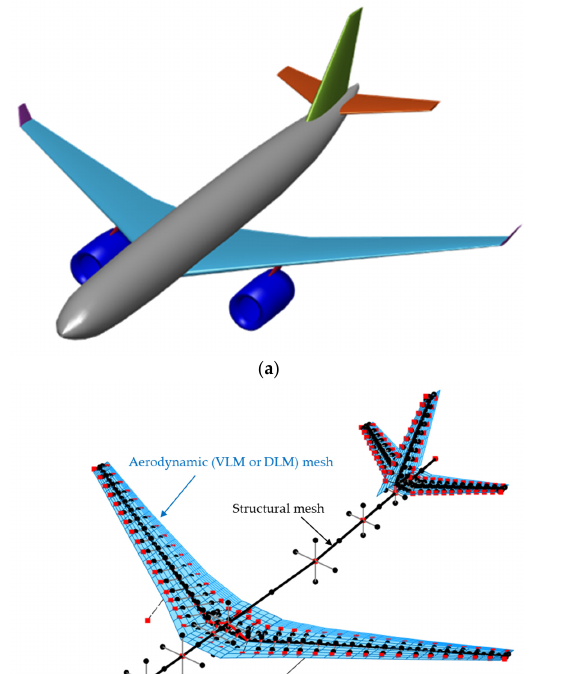
Figure 7. A330-300 tryptic view from [46]. Table 2. TALH main characteristics.